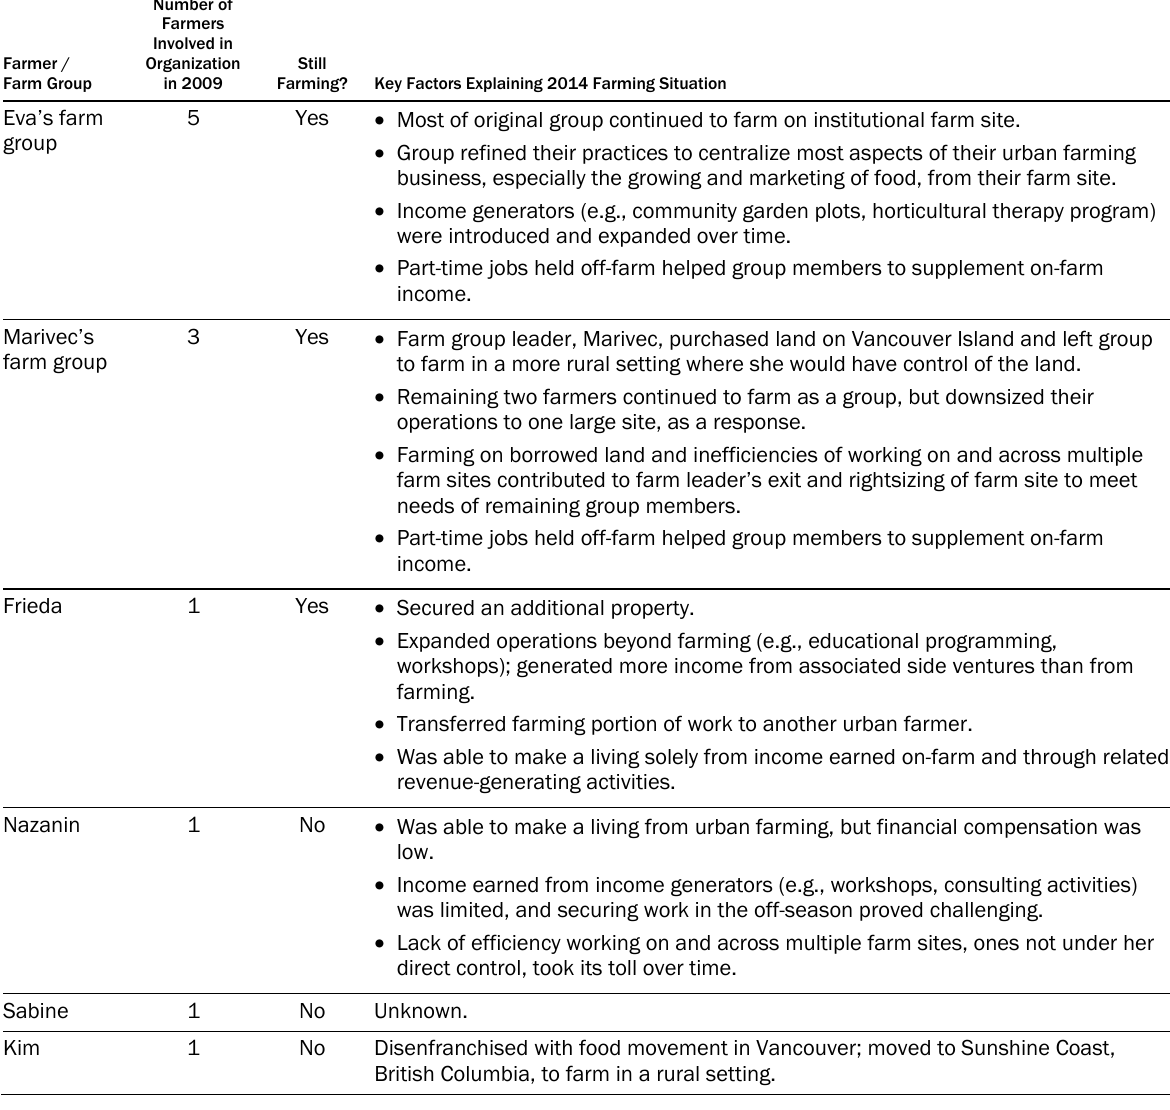
Table 2. Status of the Participating Urban Farmers in 2014 Number of Farmer / Farm Group